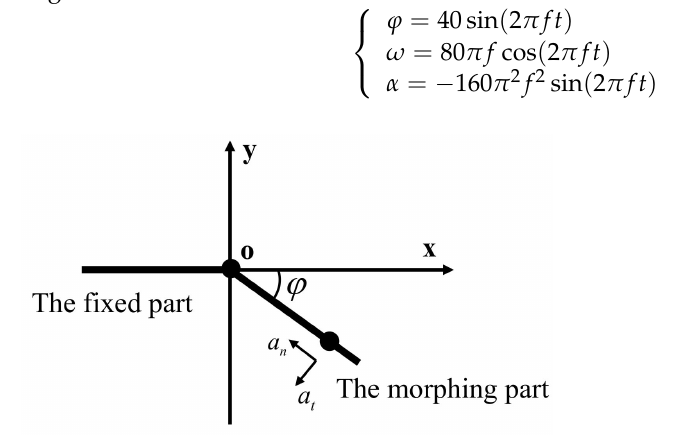
Figure 6. Diagram of inertial force in the morphing